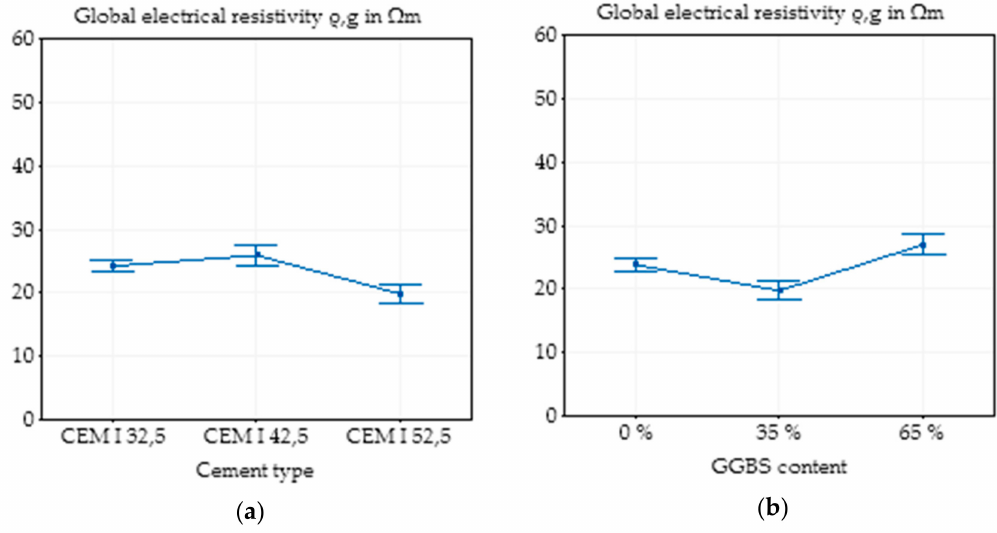
Figure A3. Main effect plot with 95% confidence interval of the cement type on the global electrical resistivity of SFRC calculated by Minitab based on all experimental data (a) and main effect plot with 95% confidence interval of the GGBS content on the global electrical resistivity of SFRC calculated by Minitab based on all experimental data ( b